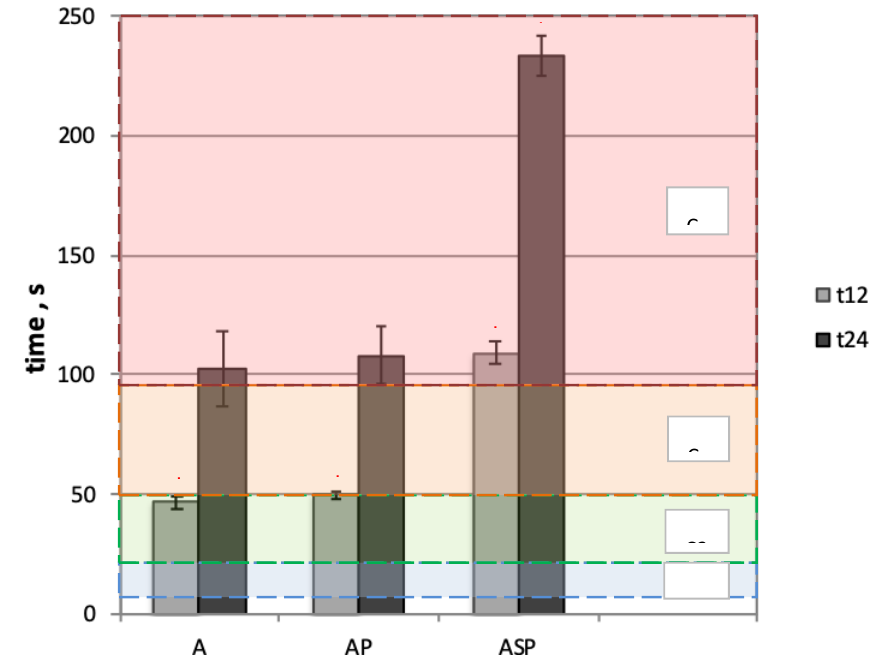
Figure 7. Test result for the time it took the calorimeter temperature to rise by 12 and 24 °C with a heat flux density of 20 kW/m 2 , where * represents a statistically significant difference (p < 0.05).